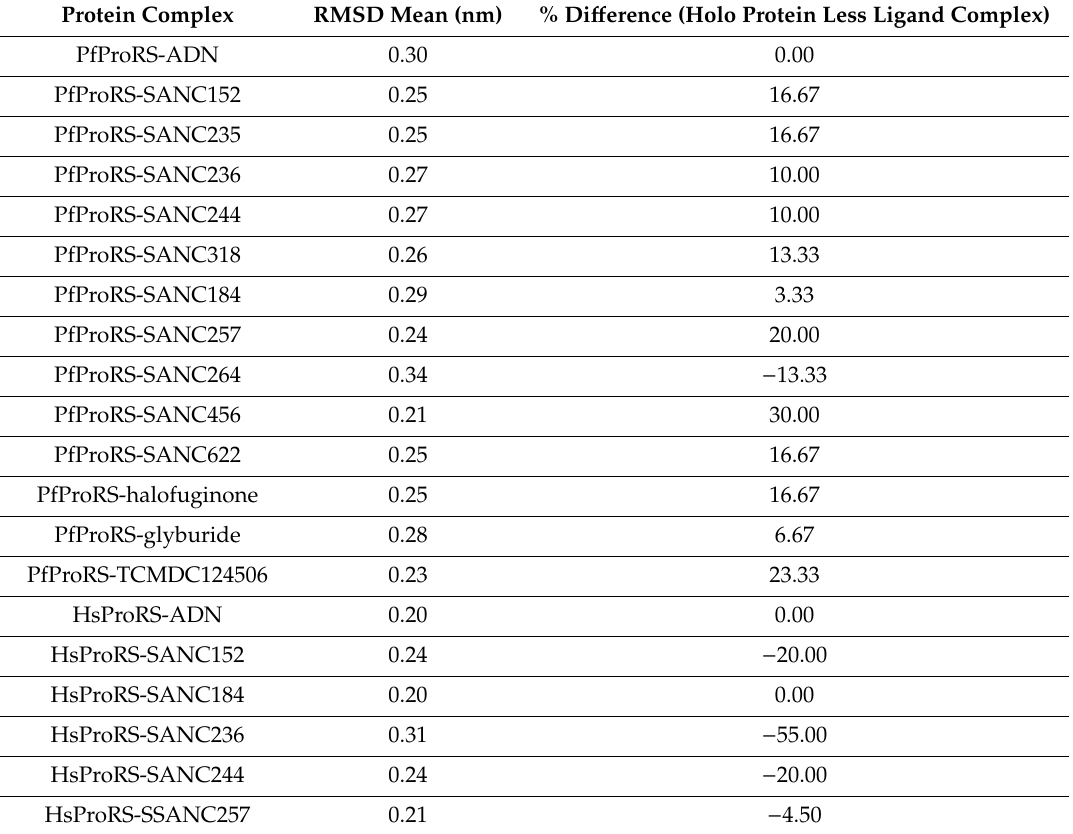
Table 2. Mean RMSD of PfProRS and HsProRS ligand complexes and average percentage di ff erences. Average % di ff erences are calculated for holo protein minus protein-ligand